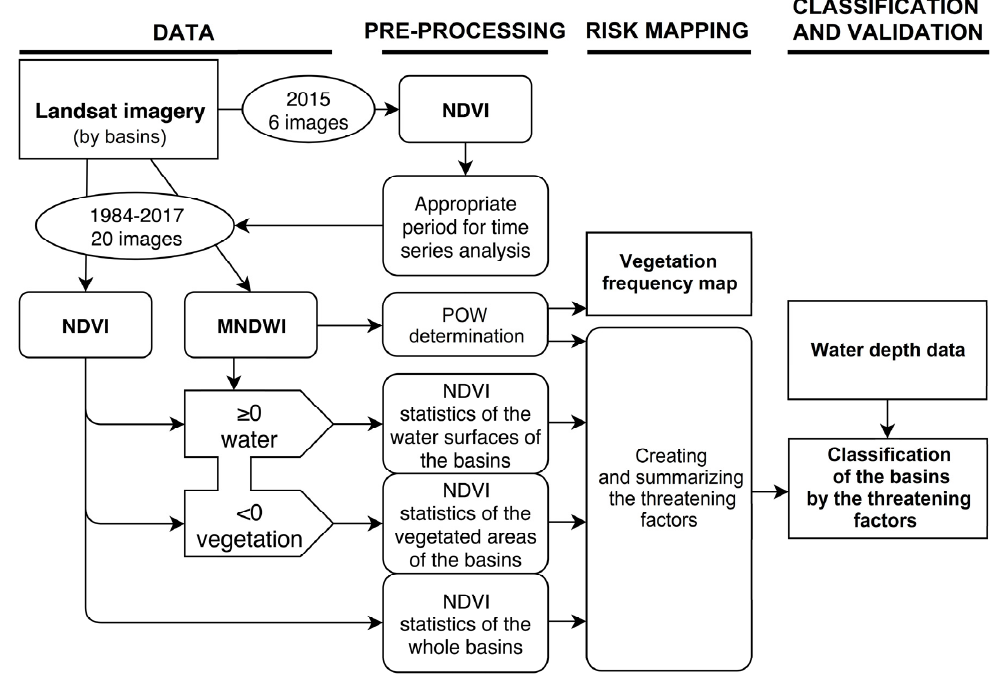
Figure 3. The workflow used in this study (NDVI, Normalized Difference Vegetation Index; MNDWI, Modified Normalized Difference Water Index; POW, Percentage of Open Water).